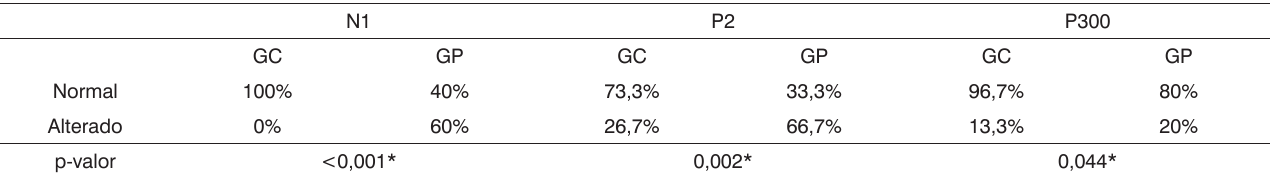
Tabela 3. Distribuição da ocorrência de resultados normais e alterados para a latência dos componentes N1, P2 e P300 do PEALL, nos